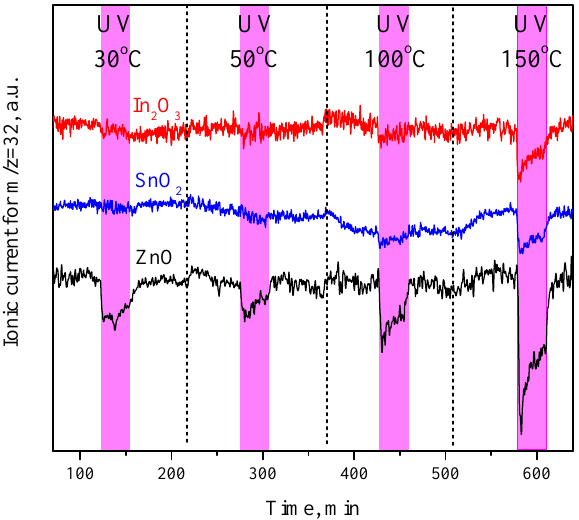
Figure 2. MS analysis of the oxygen content ( 16 O 2 , 32 a.m.u.) in the carrier gas passed through the cell with ZnO, SnO 2 , and In 2 O 3 tablets and the effect of UV irradiation on its concentration at 30, 50, 100, and 150 ◦